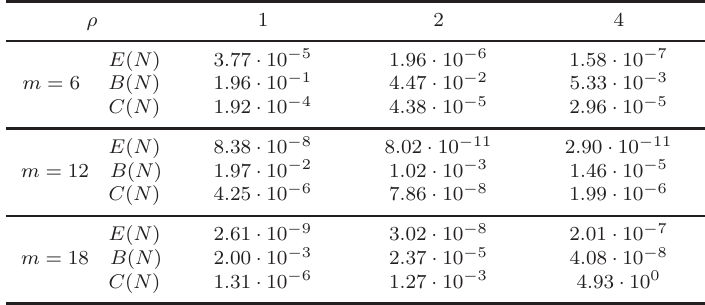
Table 5. E ( N ) , B ( N ) and C ( N ) corresponding to α opt,R , N opt,R for f ( x ) from (6.2). ρ 1 2